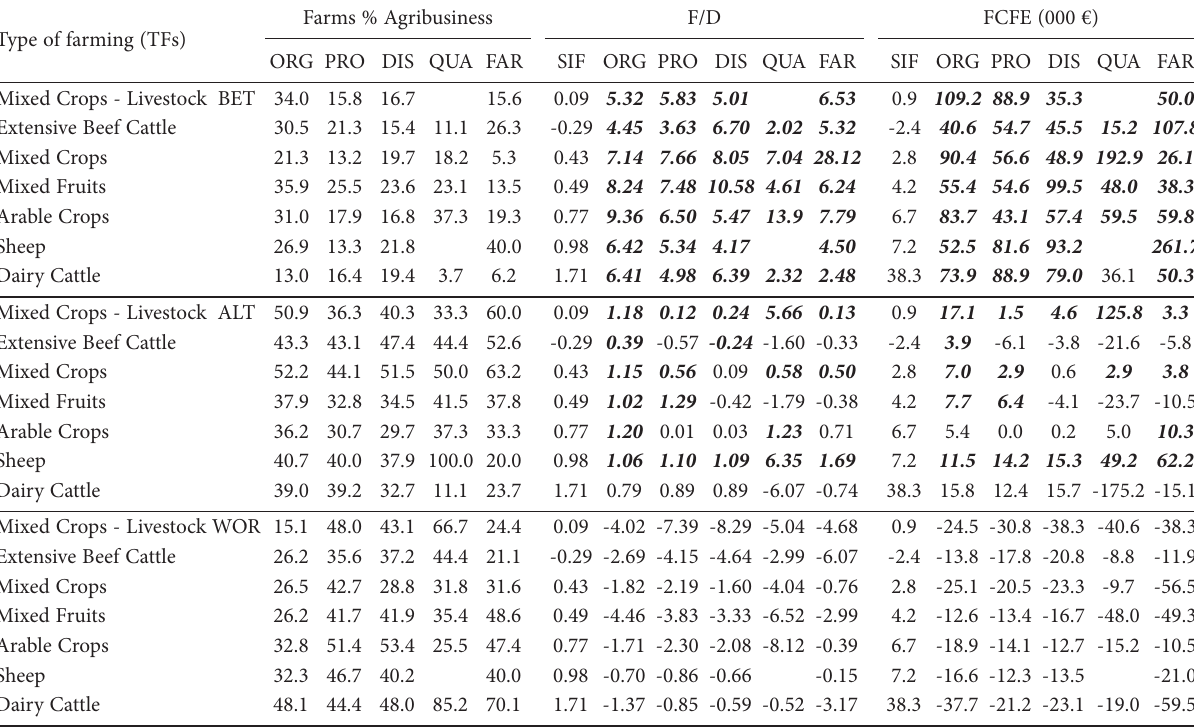
Table 7. Percentage of farms, F/D, FCFE in each financial result group in each agribusiness by TF; comparison F/D and FCFE in simple farming.